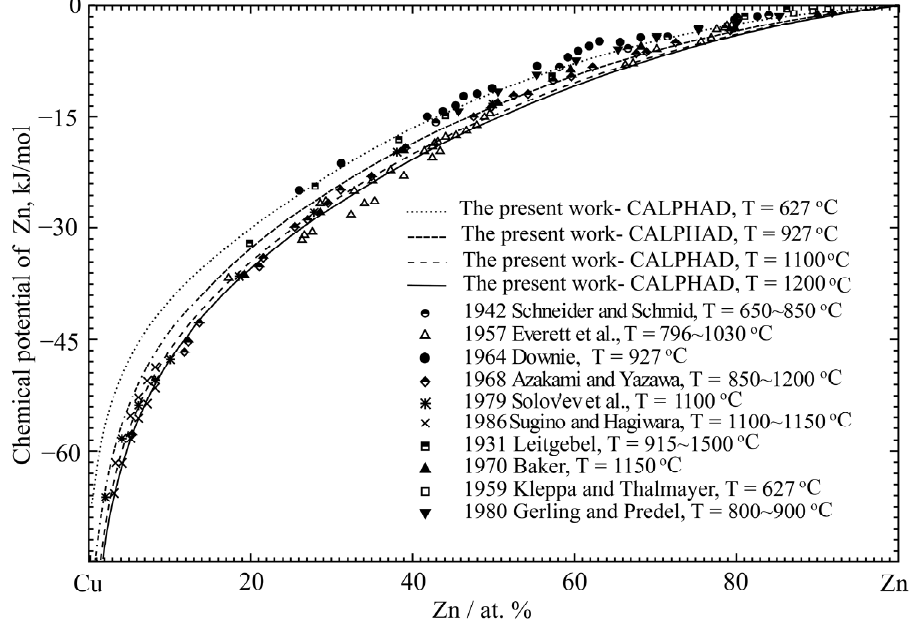
Figure 4. The calculated chemical potential of Zn for the liquid phase at 627, 927, 1100 and 1200 °C in the Cu-Zn system compared with the experimental data [61–70].